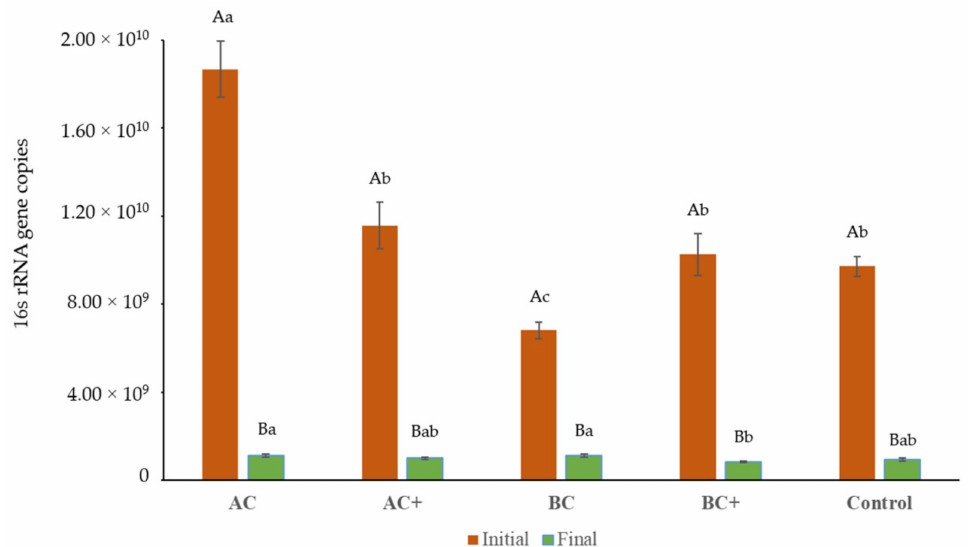
Figure 2. 16s rRNA gene copies in control soil and amended soils at low (AC and BC soils) and high doses (AC+ and BC+ soils) at two different samplings. Different lowercase letters indicate a significant difference among different treatments, and different uppercase letters indicate a significant difference between different times ( p < 0.05, ANOVA, Dunn’s post hoc Bonferroni-corrected p